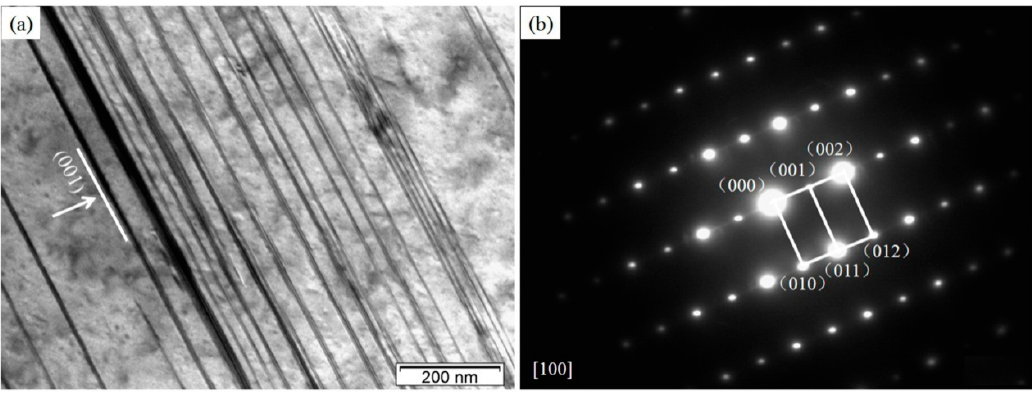
Figure 5. TEM images of the 4Gd alloy: ( a ) BF TEM image of the long period stacking ordered (LPSO) phase; ( b ) SAED pattern corresponding to the LPSO phase.